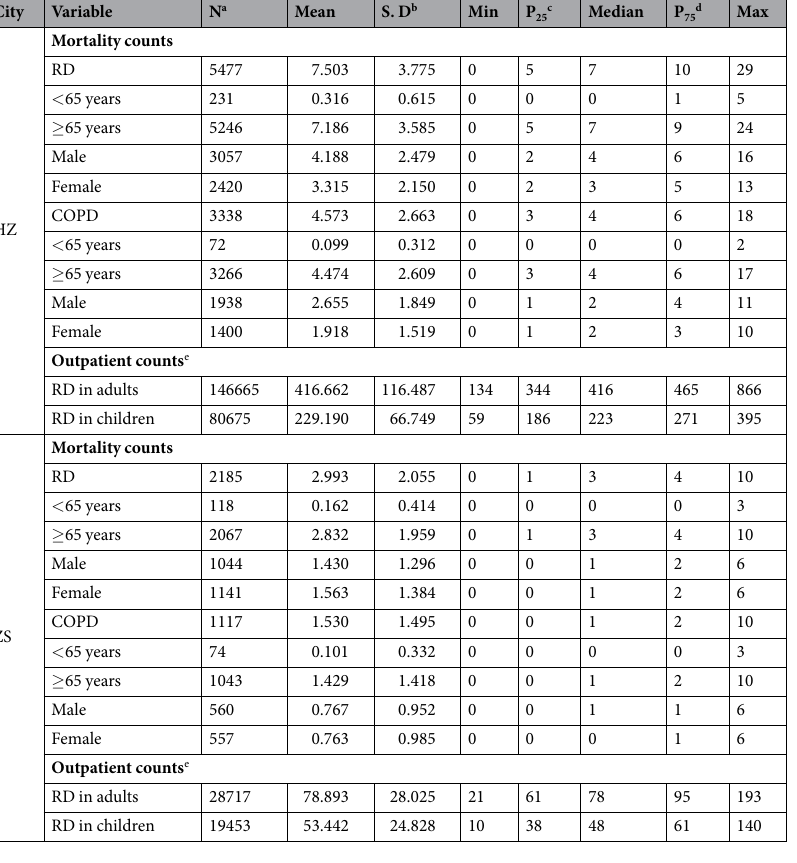
Table 3. Summary statistics of respiratory mortalities and outpatients in both cities from 2014–2015. a Observations; b Standard Deviation; c 25 th Percentiles; d 75 th Percentiles; e The data was collected in